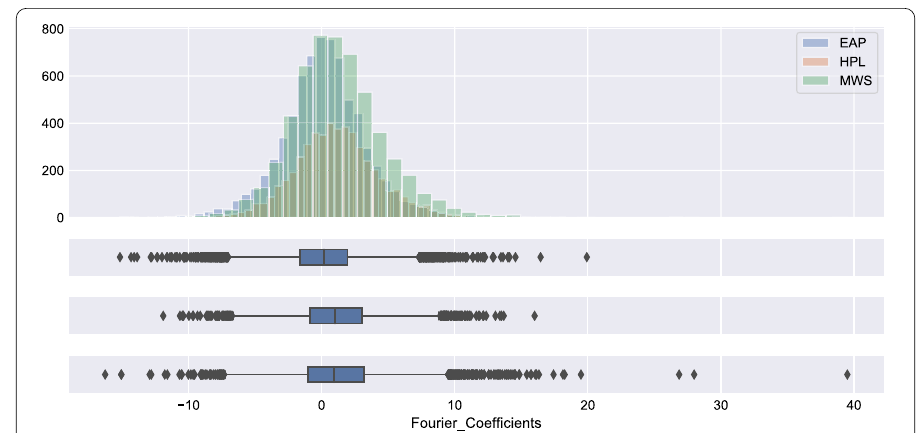
Figure 18 Distribution plot of feature “Fourier_Coefficients” from classes EAP, HPL and MWS